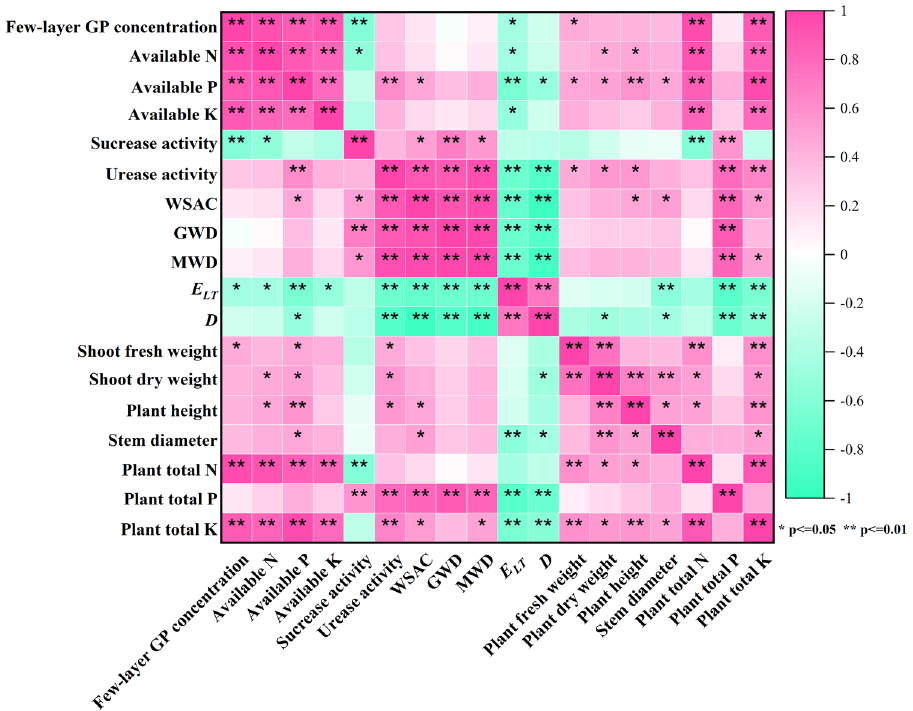
Figure 6. Correlation analysis among the indicators of few-layer graphene